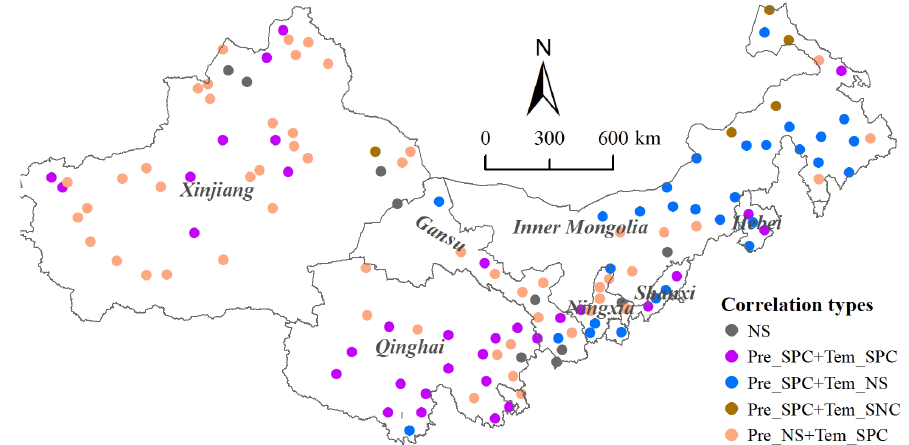
Figure 14. Partial correlation between monthly downscaled SM and precipitation and temperature (Pre – precipitation; Tem – temperature; NS – not significant; SPC – significant positive correlation; SNC – significant negative